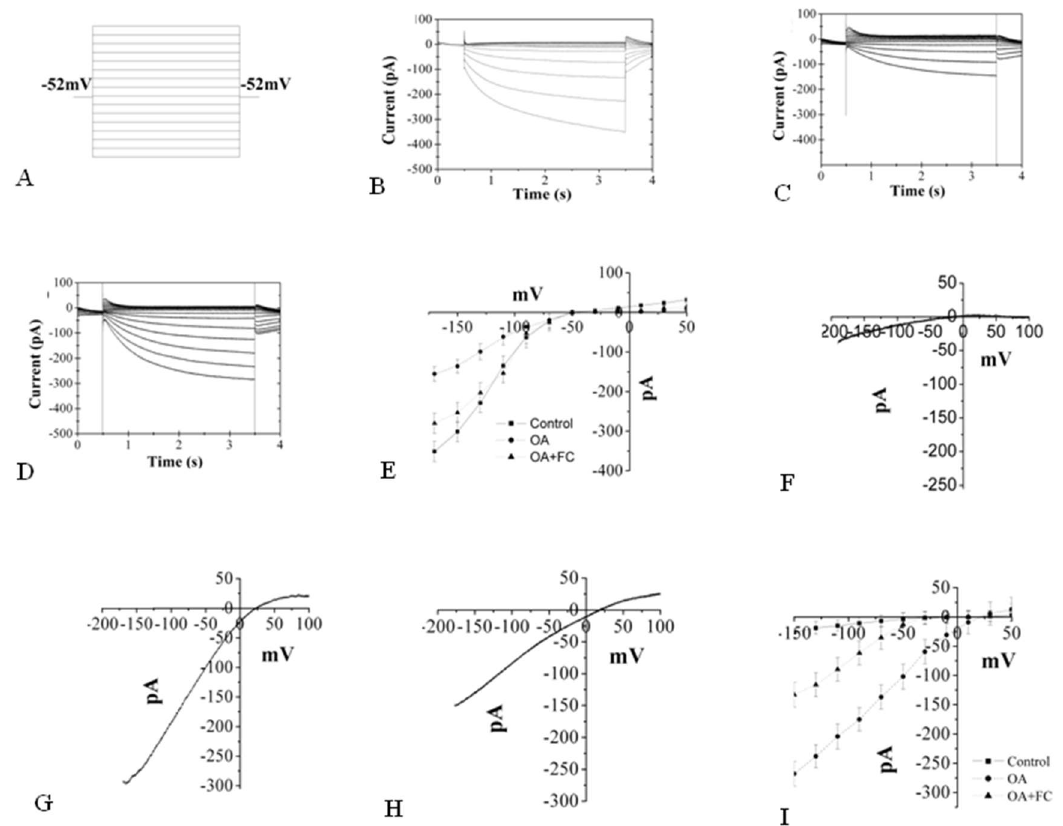
Figure 7. OA-induced changes in K + and Ca 2+ inward currents. The value of the resting membrane potential (Vm) of control cells in their culture medium was −52 mV ( A ). The inward K + current in normal condition ( B ). The inward K + current decreased obviously (from 350 pA to 150 pA) after 1 mM OA ( C ) treatment. The inward K + current recovered to 280 pA after adding FC on 1 mM OA-treated cell ( D ). Corresponding K + current-voltage relationships ( E ). The inward Ca 2+ current in normal condition ( F ). The inward Ca 2+ current increased to 300 pA after the treatment of 1 mM OA ( G ). The inward Ca 2+ current dropped to 150 pA after the addition of FC on 1 mM OA-treated cell ( H ). Corresponding Ca 2+ current-voltage relationships ( I ). Values are expressed as percentages of the control (means ± SEM).